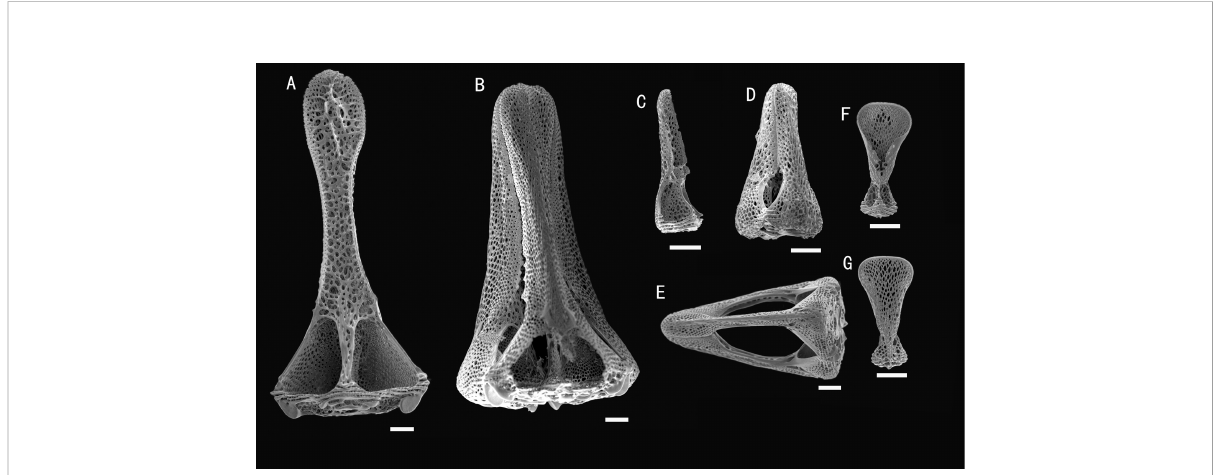
FIGURE 6 Araeosoma cucullatum sp. nov.; holotype, MBM286942. SEM images of pedicellariae. (A, B) Large tridentate pedicellaria: (A) individual valve (B) head. (C, D) Rostrate tridentate pedicellaria: (C) individual valve (D) head. (E) Involute tridentate pedicellaria. (F, G) Valves of triphyllous pedicellariae. Scale bar , 100 m m.